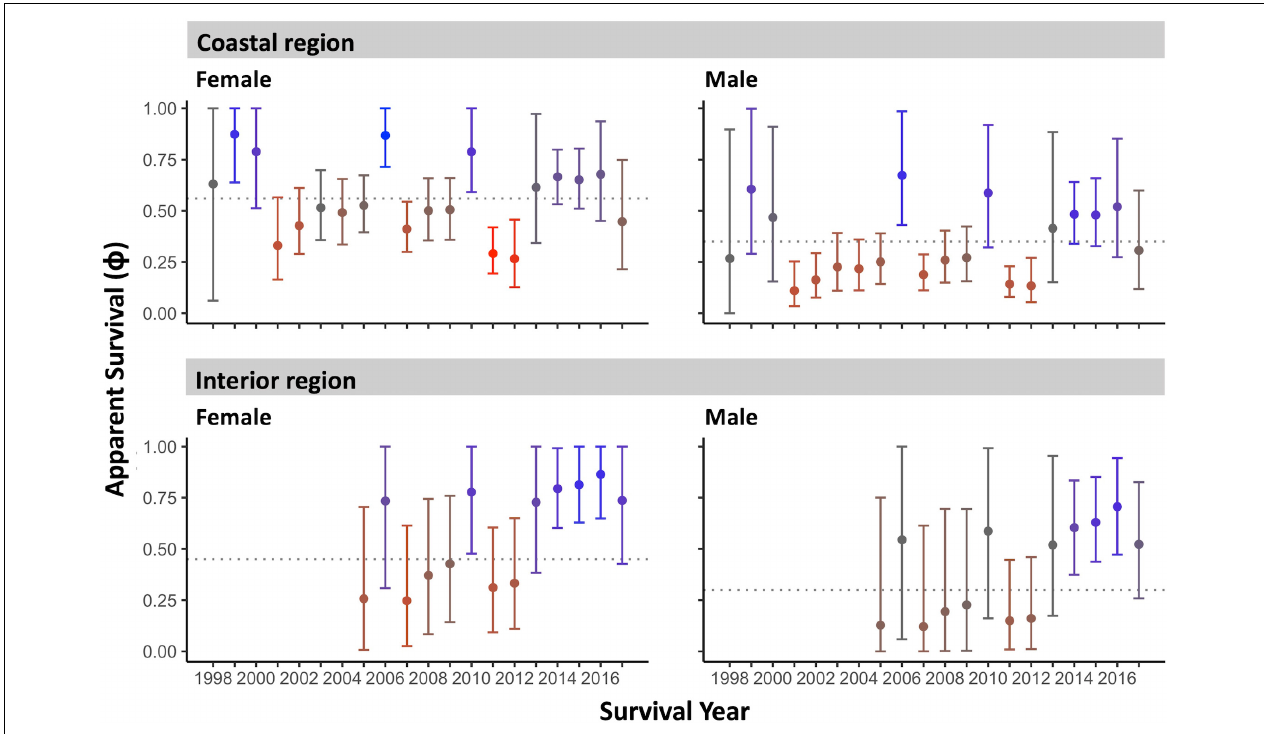
FIGURE 4 | Adult apparent annual survival (median ± 95% CI) by sex and region over the 1998–2017 monitoring period. Dashed horizontal lines indicate the group inter-annual average survival. Color coding indicates anomalously high (blue) and anomalously low (red) survival years ( see Methodology).